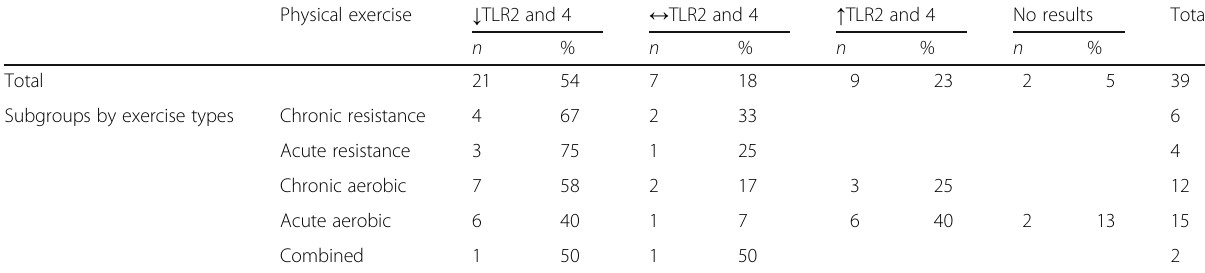
Table 3 Results of TLR2 and TLR4 expression of all eligible articles divided by type and frequency of